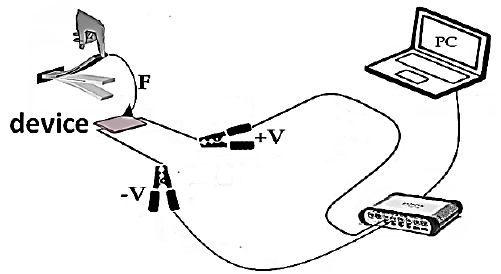
Figure 8. Schematic routes for the evaluation of the electrical properties of the devices.